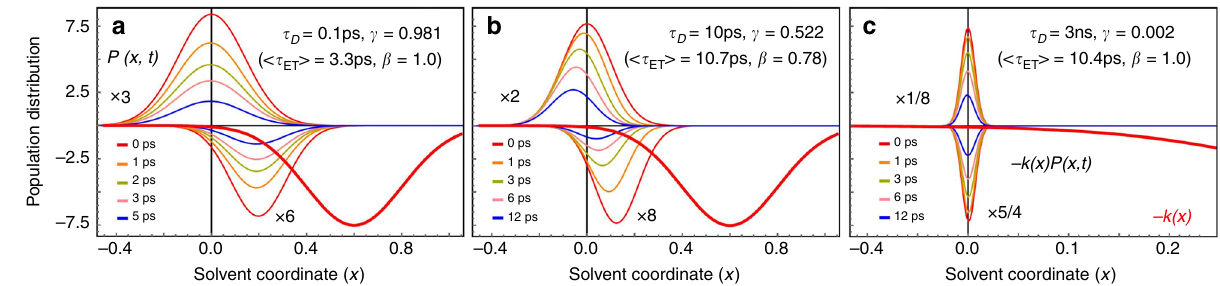
Fig. 3 Simulations of time evolution of reactants ’ distribution, P ( x , t ). The simulations are performed with different solvation timescales τ D , while values of other parameters used are the same as those in Fig. 2. The bold red line represents the curve of − k ( x ) without scaling. Within each graph, the upper panel displays the time evolution of P ( x , t ), while the lower panel displays the evolution of the reaction rate ’ s distribution, − k ( x ) P ( x , t ). a τ D = 0.1 ps. b τ D = 10 ps. c τ D = 3 ns.